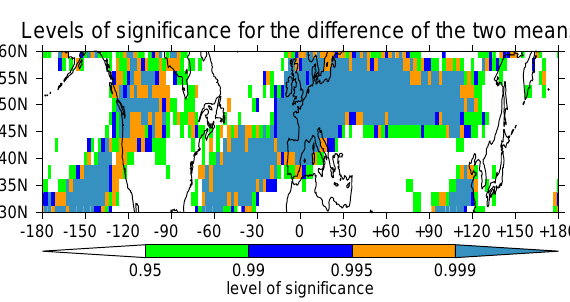
Levels of significance for the difference of the two means